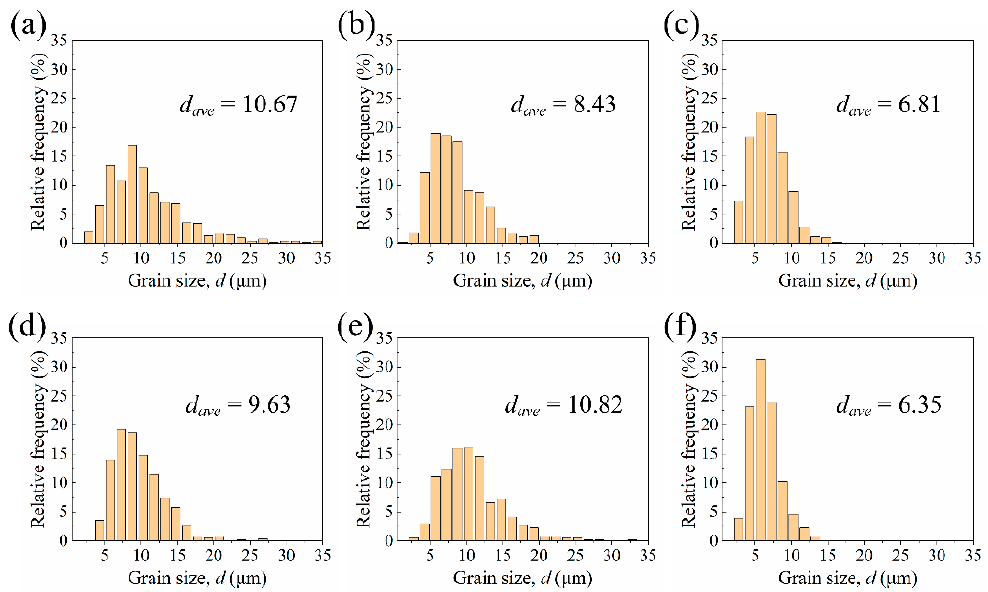
Figure 7. Grain size distributions in various stirring sub-zones of the two welded joints: ( a ) SZ1, ( b ) SZ2, ( c ) SZ3 of the ZK60/ATZ511 joint; ( d ) SZ1, ( e ) SZ2, ( f ) SZ3 of the ATZ511/ZK60 joint.